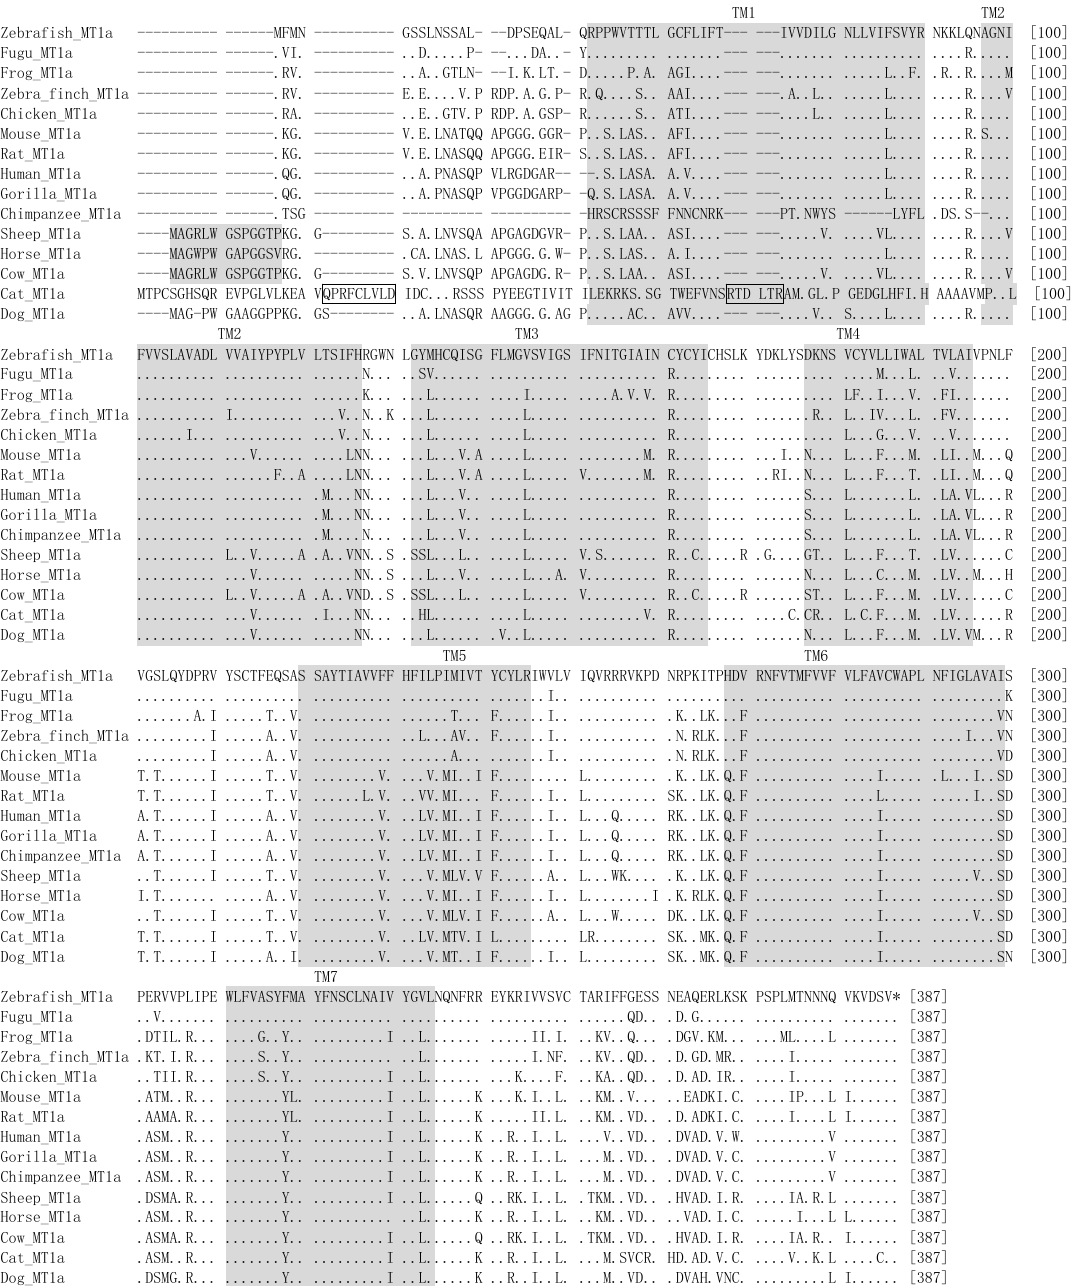
and MTNR1B , respectively. MTNR1B exhibited generally higher values than MTNR1A , being consistent with the greater number of SNPs in human MTNR1B than human MTNR1A . Standard errors from 1000 bootstrap replicates, shown above the diagonal, ranged from 0.003 to 0.015, but most of them exceeded